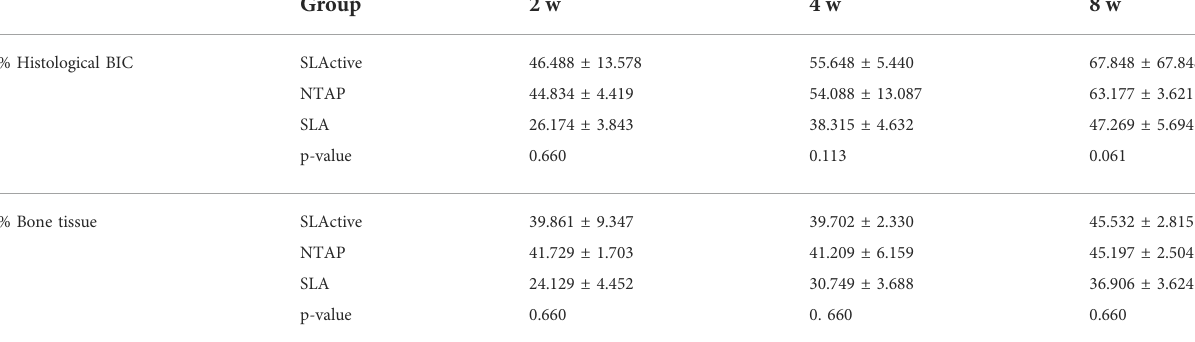
TABLE 2 Percentage of histological BIC and bone tissue in different groups: 2-week healing, 4-week healing, and 8-week healing in implant